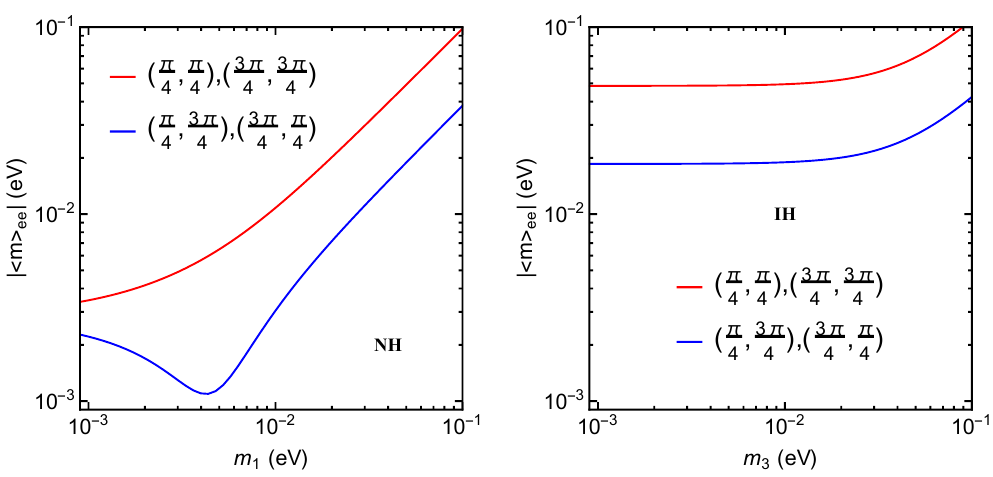
in the NH case or m in the IH 1 3